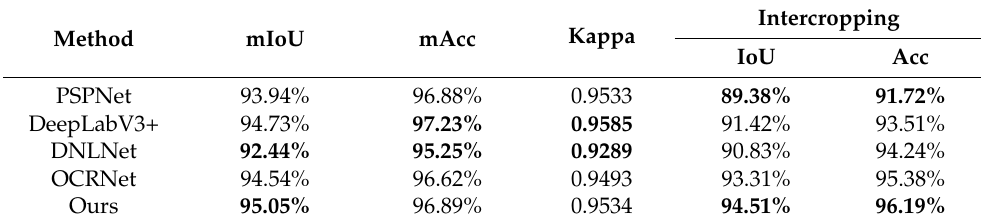
Table 3. Semantic segmentation accuracy results for test area